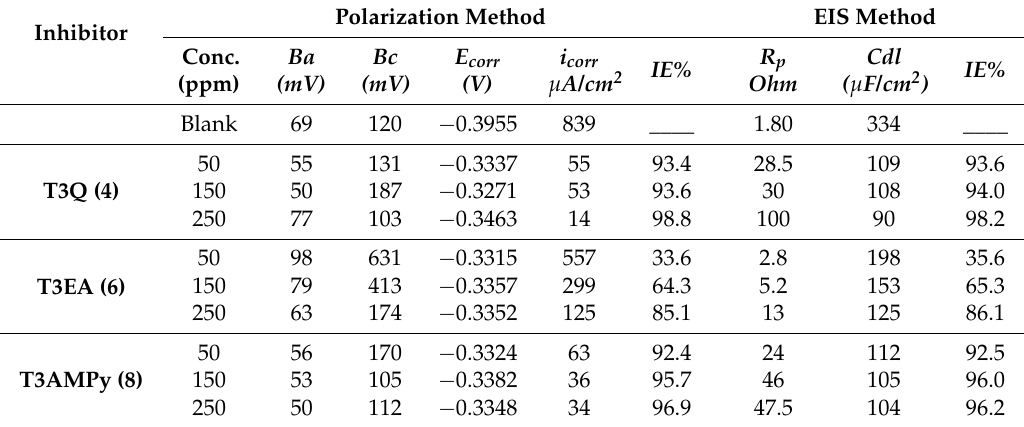
Table 1. The effect of T3Q, T3EA and T3AMPY concentrations on the IE% values for steel in acidic chloride solutions using electrochemical methods .